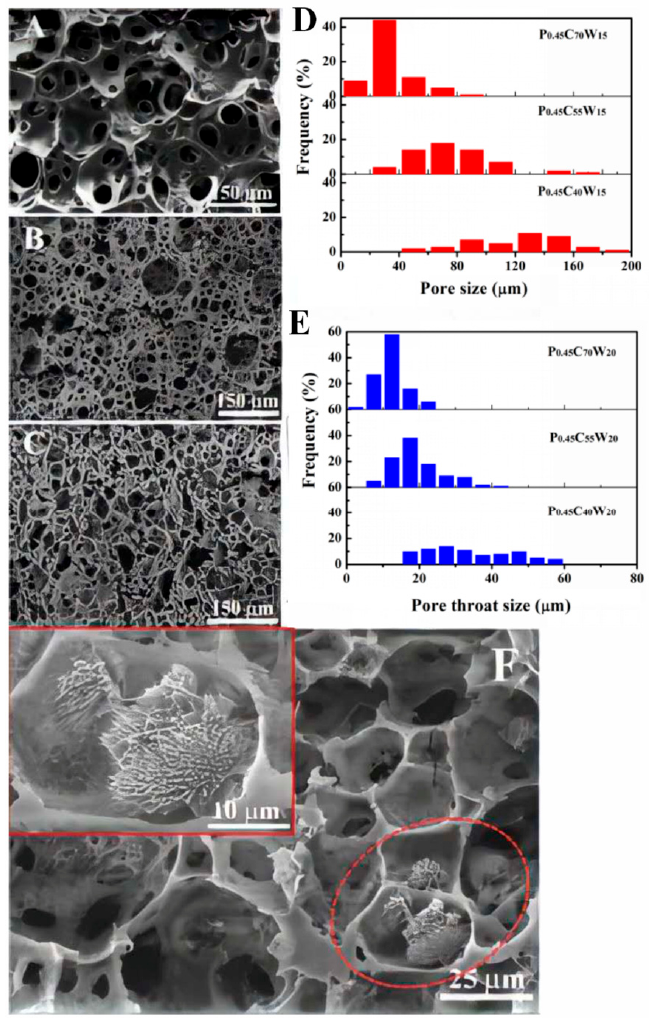
Figure 5. The SEM images of ( A ), ( B ), and ( C ) of P 0.45 C y W 20 templated from C/W HIPEs containing 40, 55, and70 g CO 2 , respectively; ( D ) and ( E ) are the distribution charts of pores and pore throats, respectively; ( F ) the secondary pore structure of P 0.45 C 70 W 20 templated from C/W HIPEs containing 70 g CO 2 . Table 1. Micro-morphological characteristics of different Ca-BDC/polyHIPEs were measured and counted from corresponding SEM images.